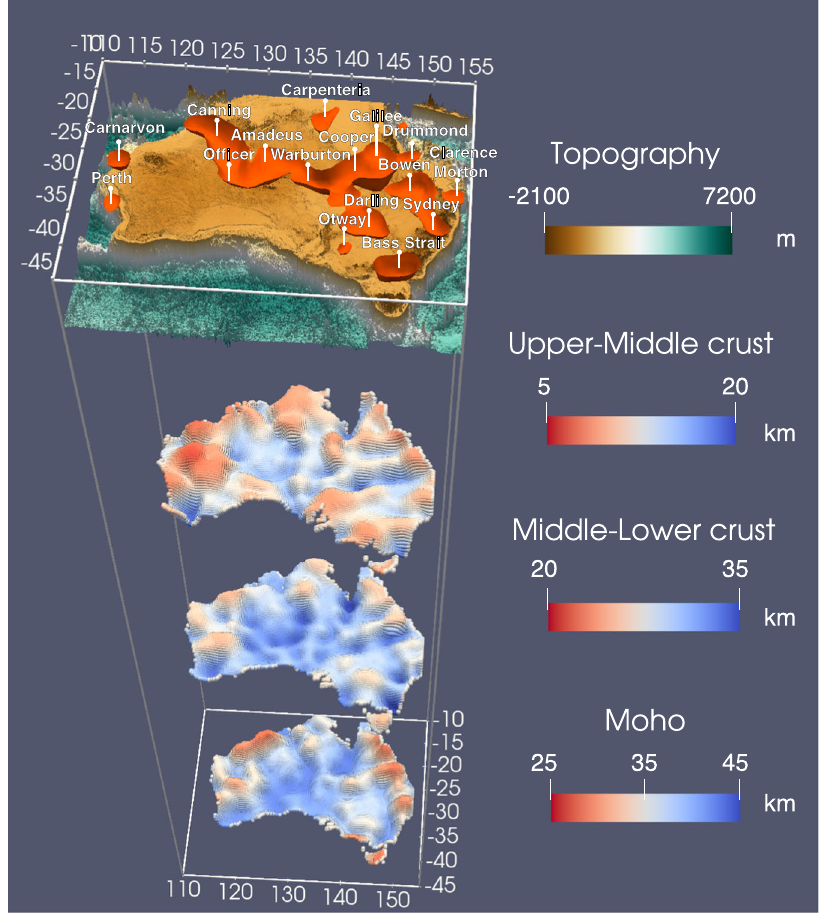
Fig. 10 | A 3D rendering ofthe shear velocitymodel. The sedimentary basins are represented by an isosurface of 3.1km/s. The four interfaces are, from the top to